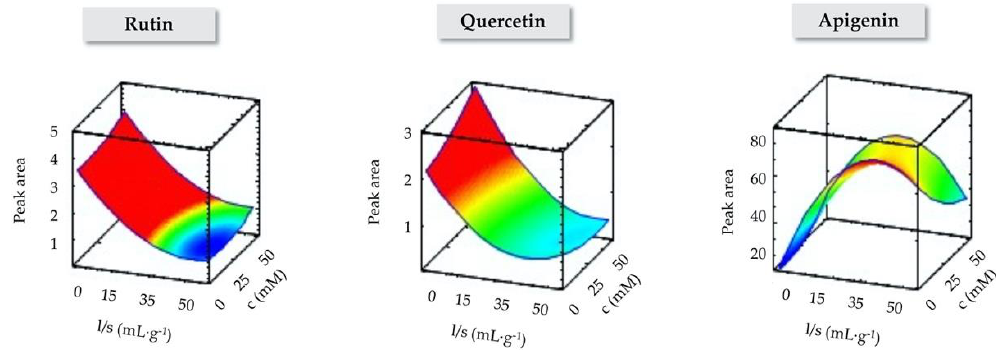
Figure 1. Representative response surfaces described by the second order multivariate regression equation, obtained for each target flavonoid, showing the dependency of the peak area with the IL concentration (c, mM) and the liquid/solid (l/s, mL·g −1 ) ratio.